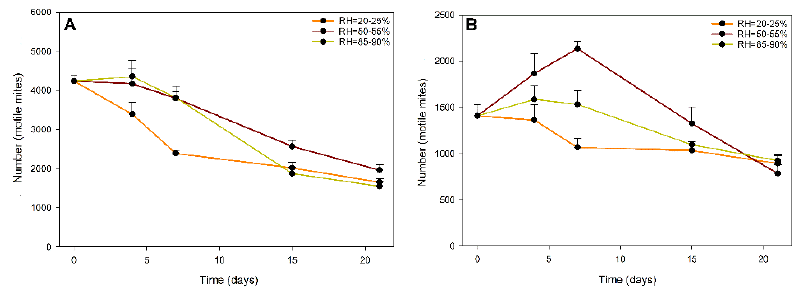
Figure 2. Total numbers of motile mites/sachet (means) of the prey mite Carpoglyphus lactis ( A ) and the predatory mite Amblyseius swirskii ( B ) inside slow-release sachets subjected to three levels of RH, namely, low (22.5%), medium (52.5%) and high (87.5%), in laboratory trials under controlled conditions (temperature = 25 ± 1 °C) (whiskers show the SE values).